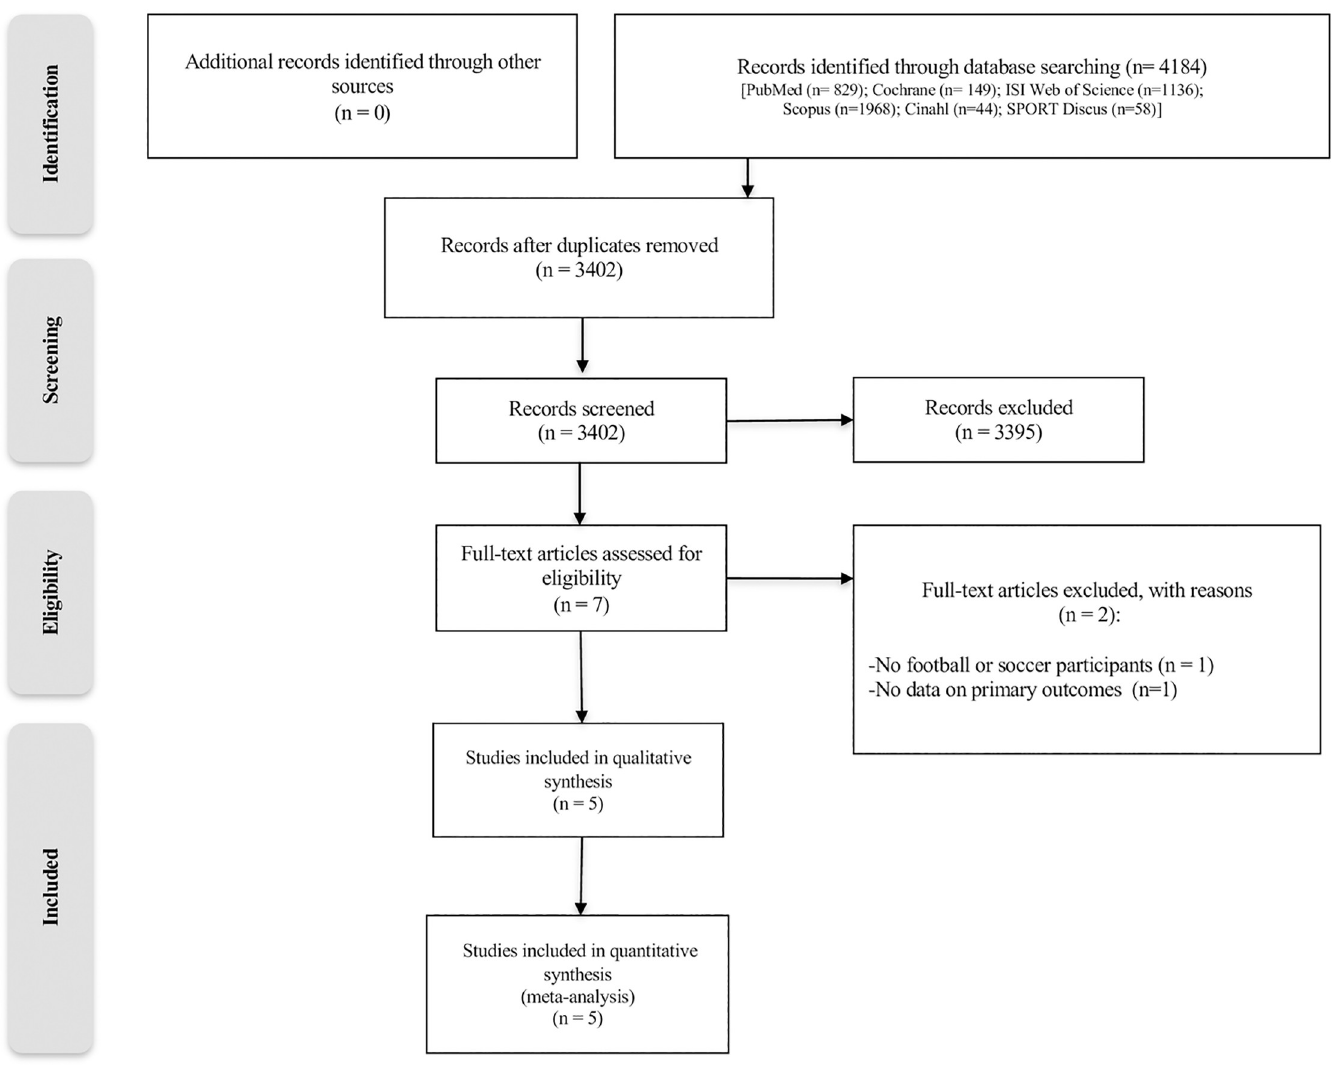
Fig 1. Eligibility flow diagram showing the selection process for the inclusion studies in this meta-analysis. n: sample size.